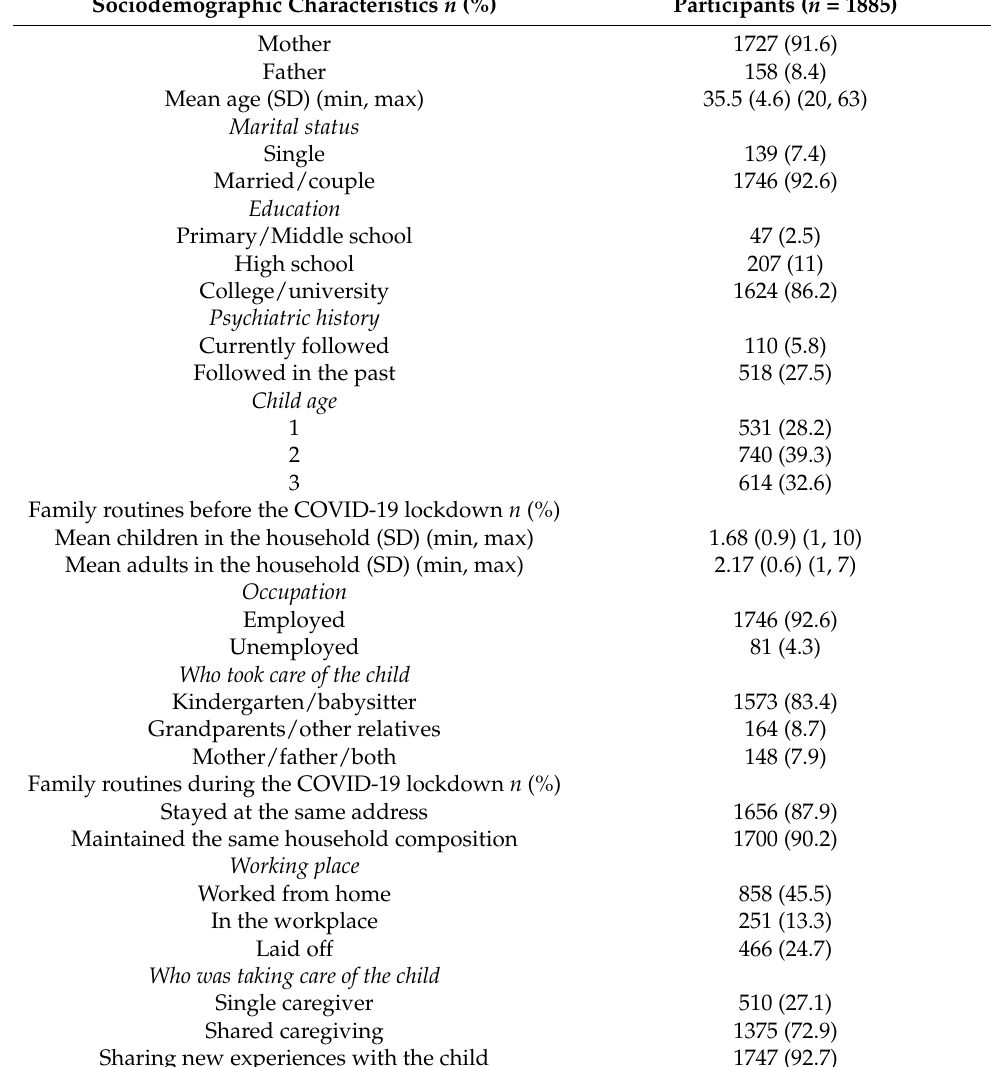
Table 1. Baseline characteristics of study